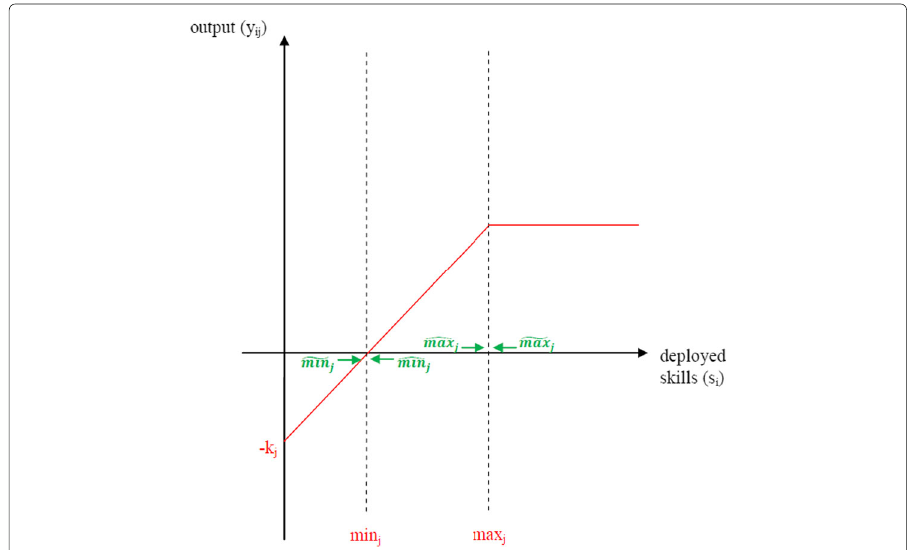
Fig. 4 Alternative estimators of job